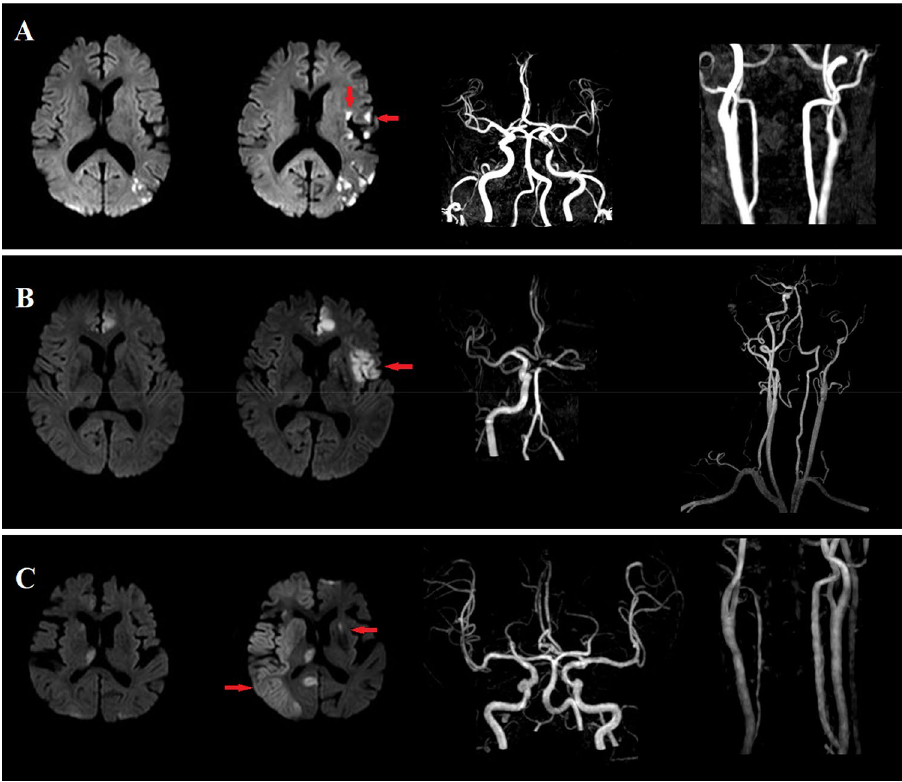
Figure 2. Representative cases of ERIL-same and ERIL-different. (A) This patient belongs to the IC-LAA group, and new lesions on follow-up MRI are occurring in the same vascular territory where the index lesion belongs: ERIL-same. (B) In this patient belongs to the EC-LAA group, a new lesion is detected in the left proximal ICA area, a relevant vascular territory: ERIL-same. (C) In this patient from the CE group, follow-up MRI lesions are detected outside the vascular territory of the index lesion: